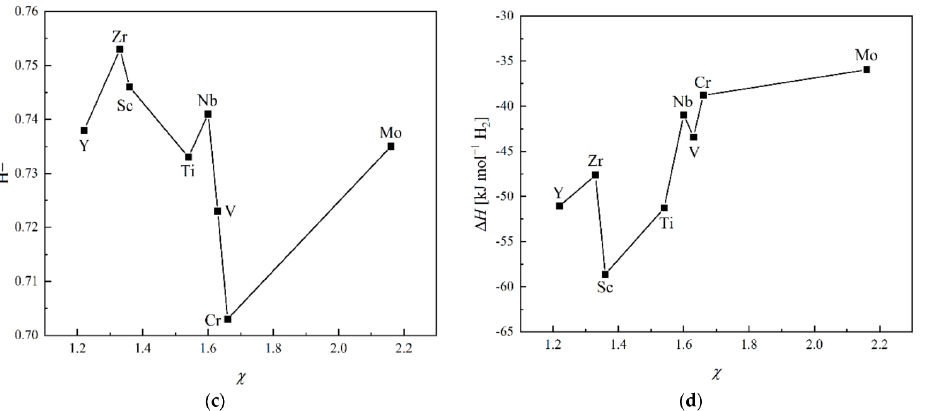
Figure 18. ( a ) The empirical radius ( r ) and electronegativities ( χ , Pauling scale) of TM elements. The empirical radiuses of TM elements come from reference [125]. The electronegativity (Pauling scale) of TM dopant elements come from reference [202,203]. Charge densities of ( b ) TM and ( c ) H in Mg 15 TMH 32 are presented in Table 4. ( d ) Heat of formation of Mg 15 TMH 32 is presented in Table